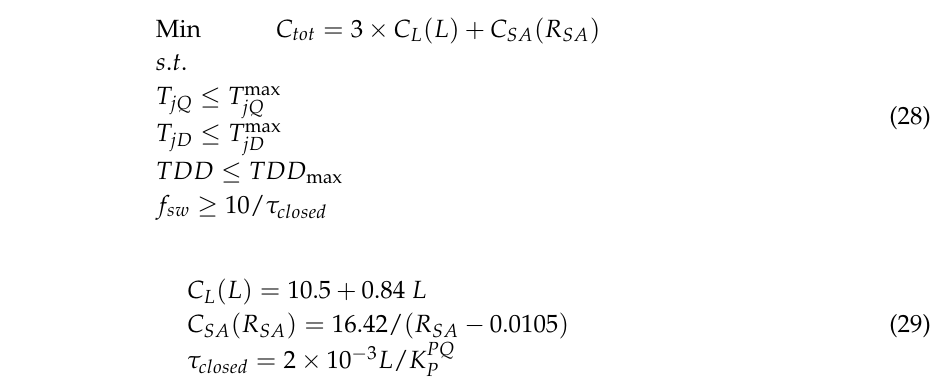
Figure 9. TDD versus the ambient temperature for different switching frequencies.